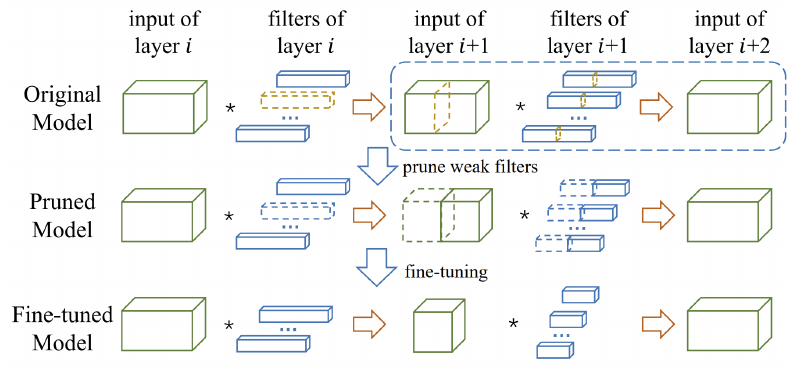
Figure 3. Example of Structural Pruning (ThiNet: statistics of layer i + 1 are used to guide the pruning in layer i ). (Reprinted from ref.